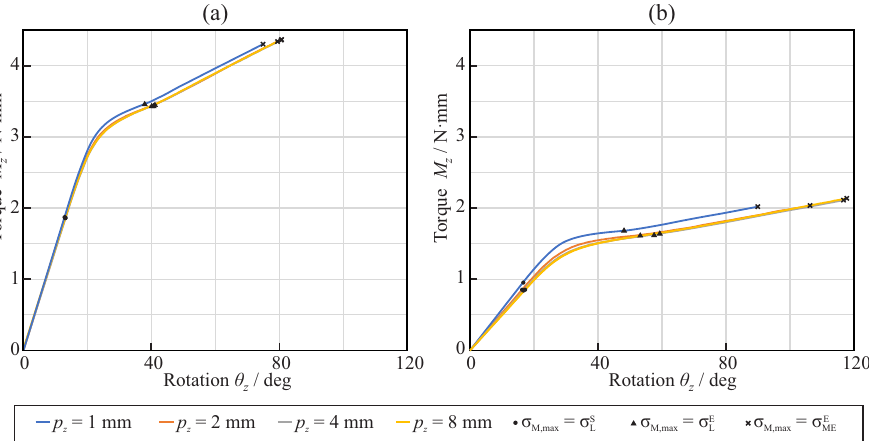
Figure 11. Torque–rotation relationships for the torsional analysis of endodontic files with different axial pitch: squared cross-section ( a ) and triangular cross-section ( b